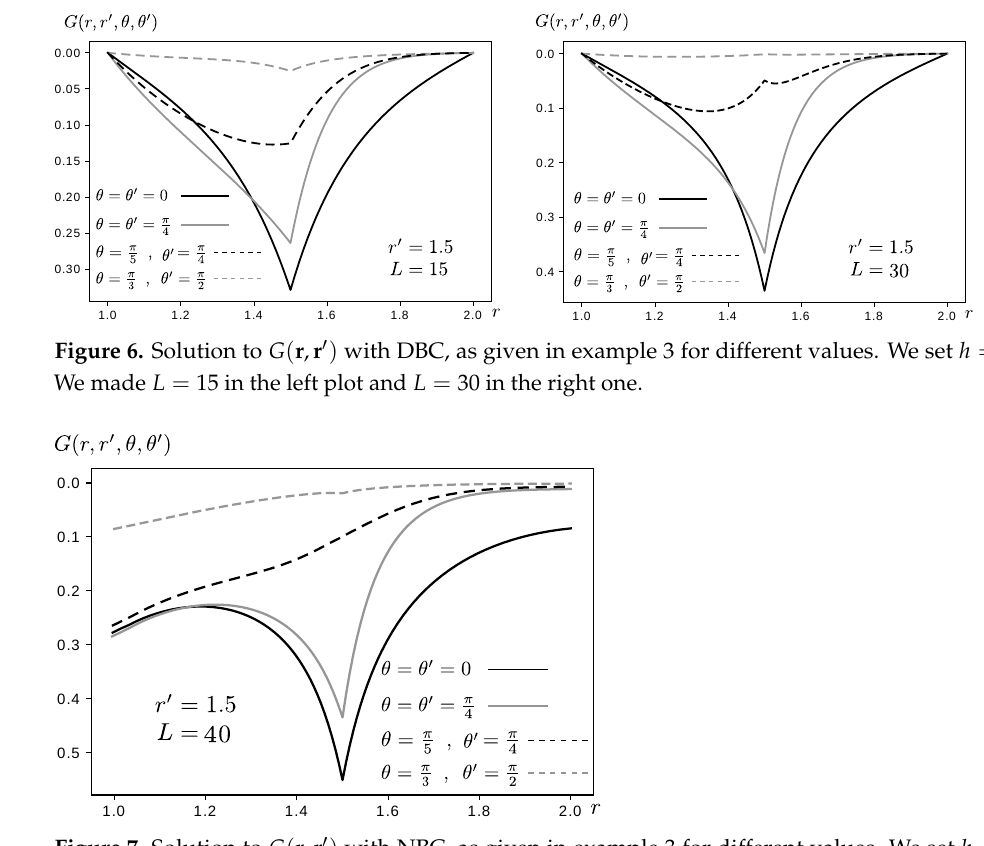
Figure 7. Solution to G ( r , r (cid:48) ) with NBC, as given in example 3 for different values. We set h = 1 and made L =